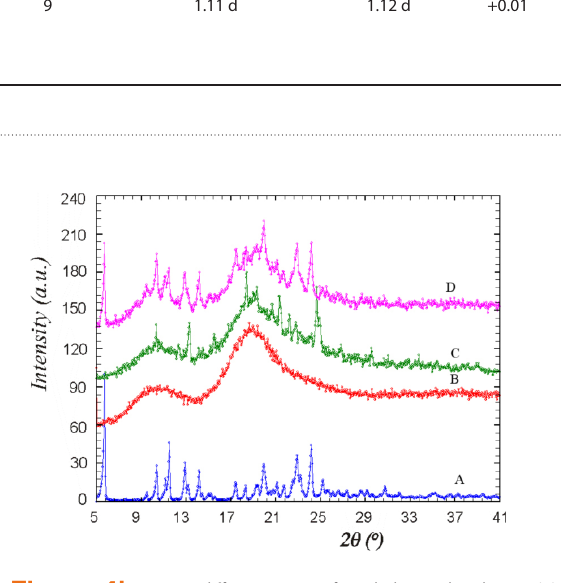
Figure 4b. X-ray diffractograms of amlodipine besylate